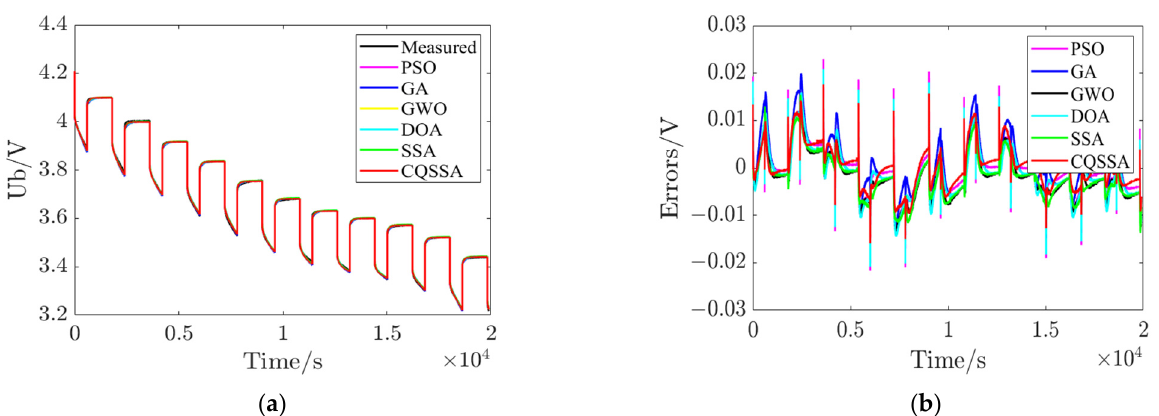
Figure 7. The comparison of estimated and measured voltages under PULSE test. ( a ) The comparison of measured and estimated terminal voltages. ( b ) The comparison of terminal voltage errors of six algorithms. Table 7. Terminal voltage errors with six different groups of FOM parameters under PULSE test.